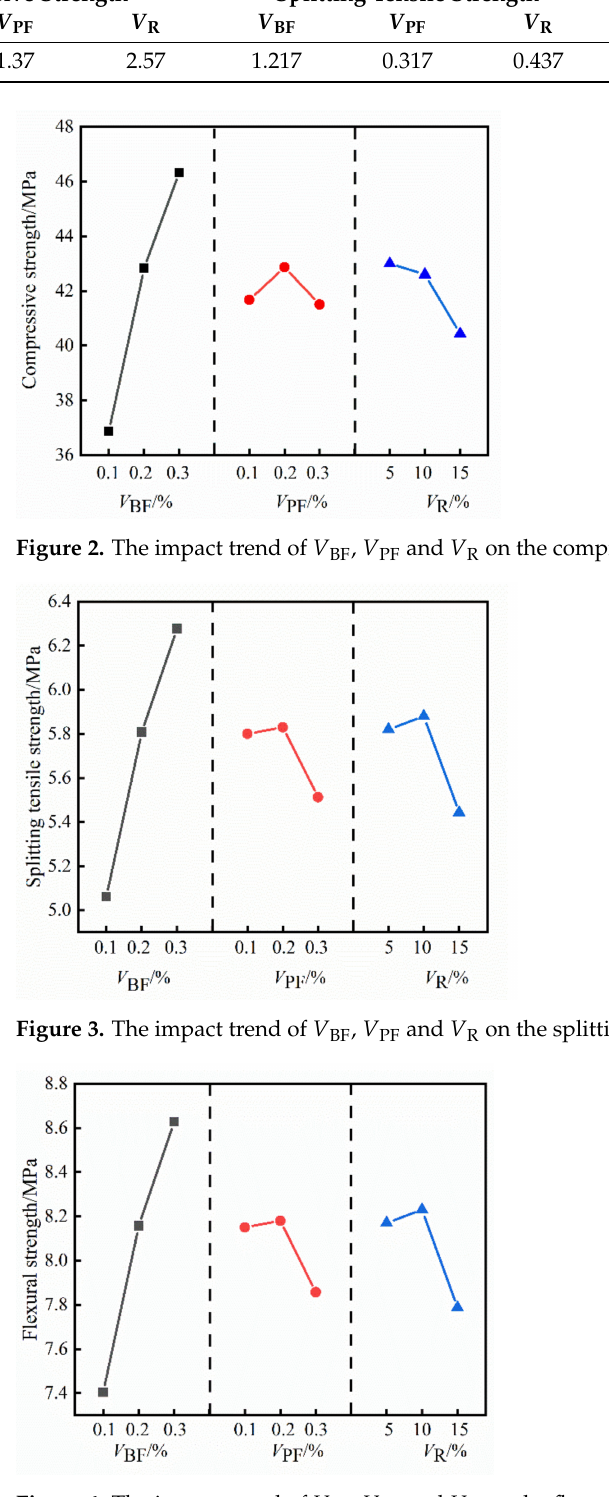
Figure 4. The impact trend of V BF , V PF and V R on the flexural strength of